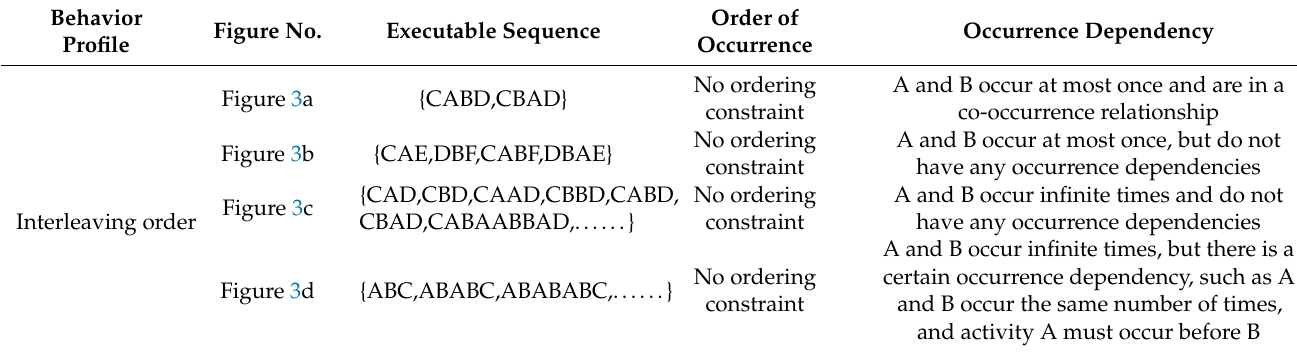
Table 2. The relationship between activity A and activity B shown in Figure 3.